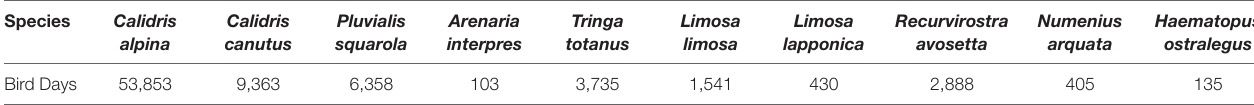
TABLE 2 | Bird-days estimated for each species recorded foraging within the survey area between the 20th of January and the 3rd of April 2017 on the mudflat adjacent to Geedon Saltings at Fingringhoe Wick Essex Wildlife Trust Nature Reserve, Essex, United Kingdom (grid reference TM 05065 19030).